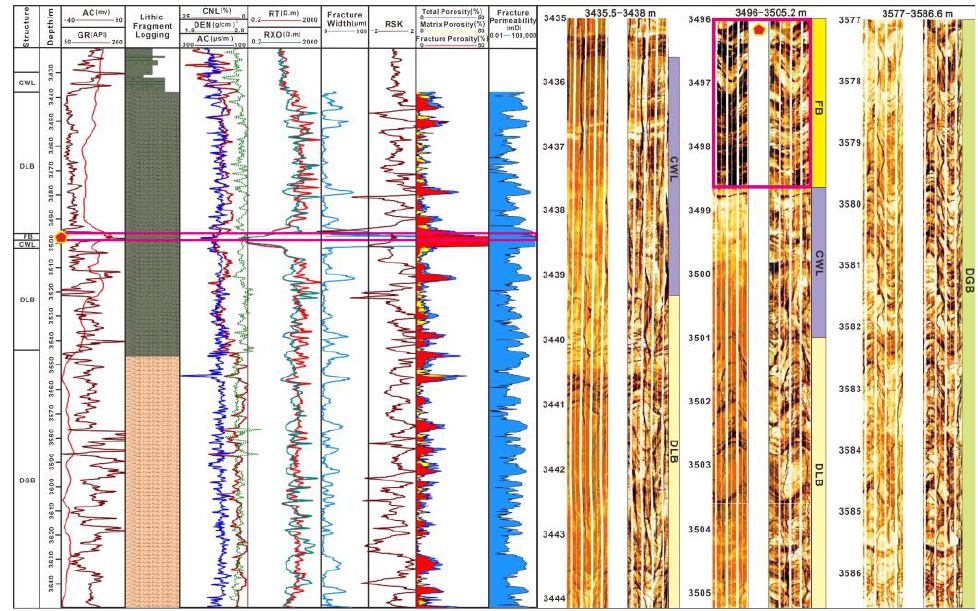
Figure 13. Identification of fault belts and characterization of their physical properties from the logging dataset. CWL: complete weathering layer, FB: fault belt, DLB: dissolution belt, DGB: disinte- gration belt.